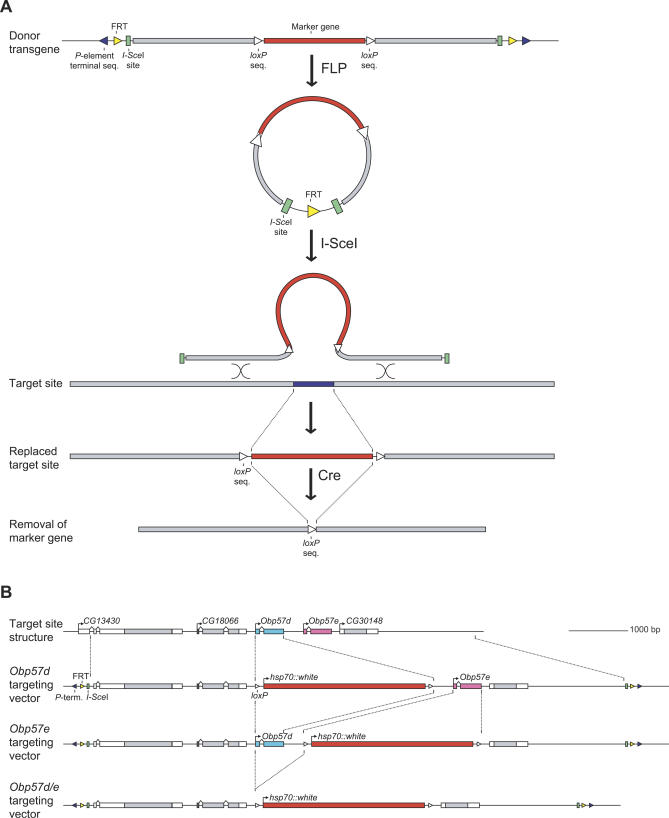
Generation of Obp57d/e Knock-Out Flies by Gene Targeting(A) Targeted gene replacement by the ends-out method. A donor transgene integrated into the other chromosome by P element–based transformation was excised by the FLP recombination enzyme at FLP recognition target (FRT) sites. Resulting circular DNA was linearized by I-SceI, inducing a precise replacement of a target gene with a marker gene. Finally, a marker gene was excised by Cre recombinase that recognizes loxP sequences, leaving a single 34-bp loxP sequence.(B) Vector structures for Obp57d/e-targeted mutagenesis.